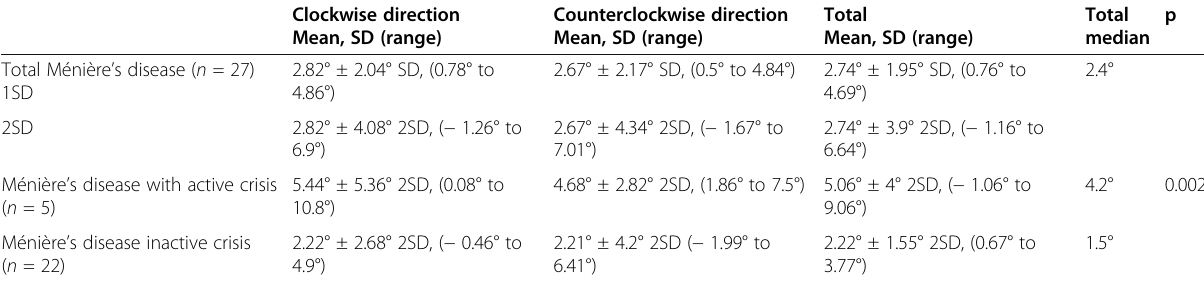
Table 3 Mean measurements in clockwise and counterclockwise directions in Ménière ’ s disease, based on 1SD and 2SD Clockwise direction Mean, SD (range)